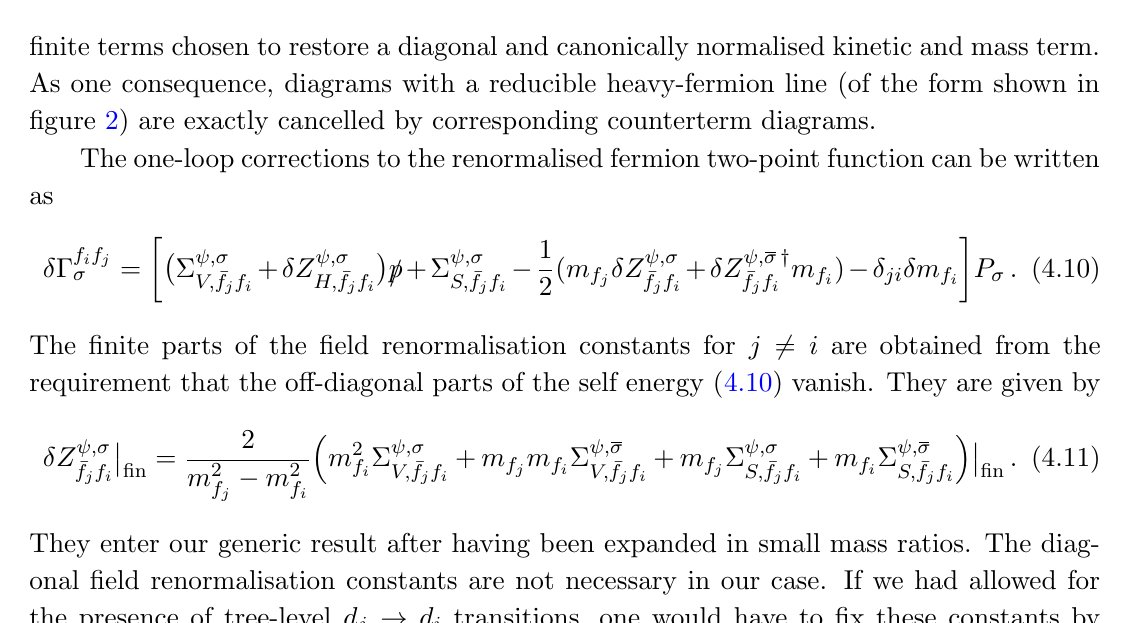
Figure 2 . One-heavy-particle reducible contribution to the Z